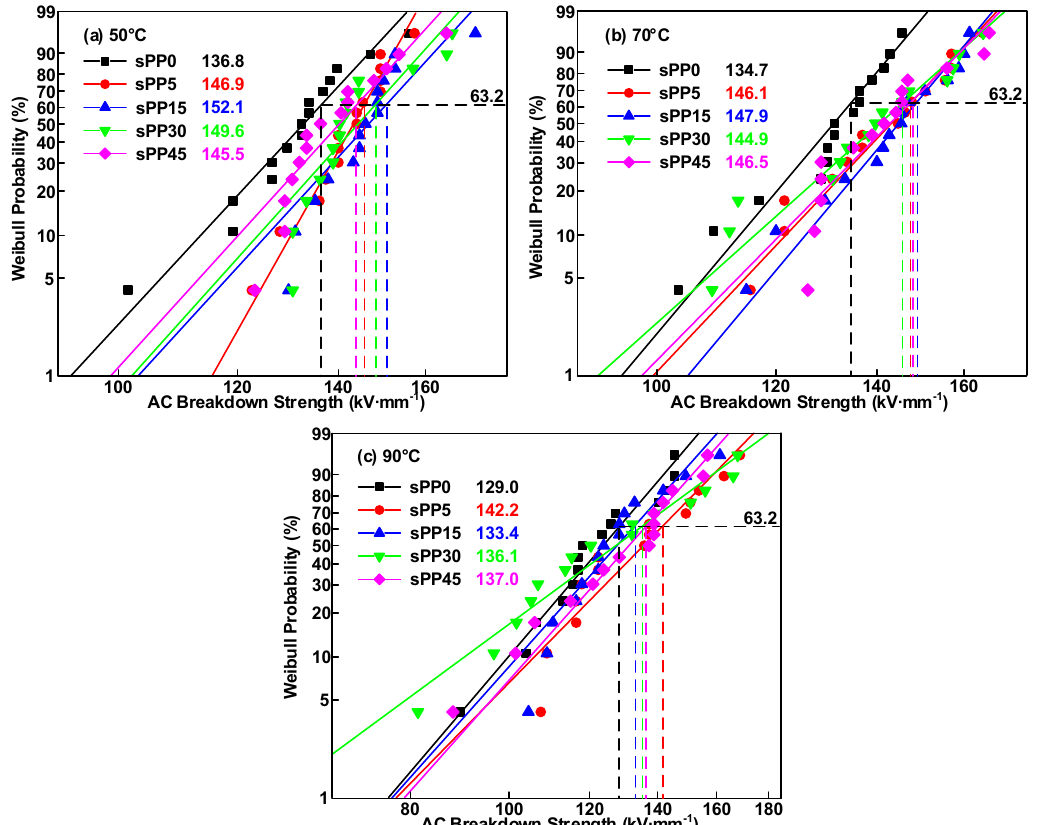
Figure 7. Weibull distribution of AC breakdown strength in iPP/sPP blends. ( a ) 50 °C, ( b ) 70 °C, ( c ) 90 °C.